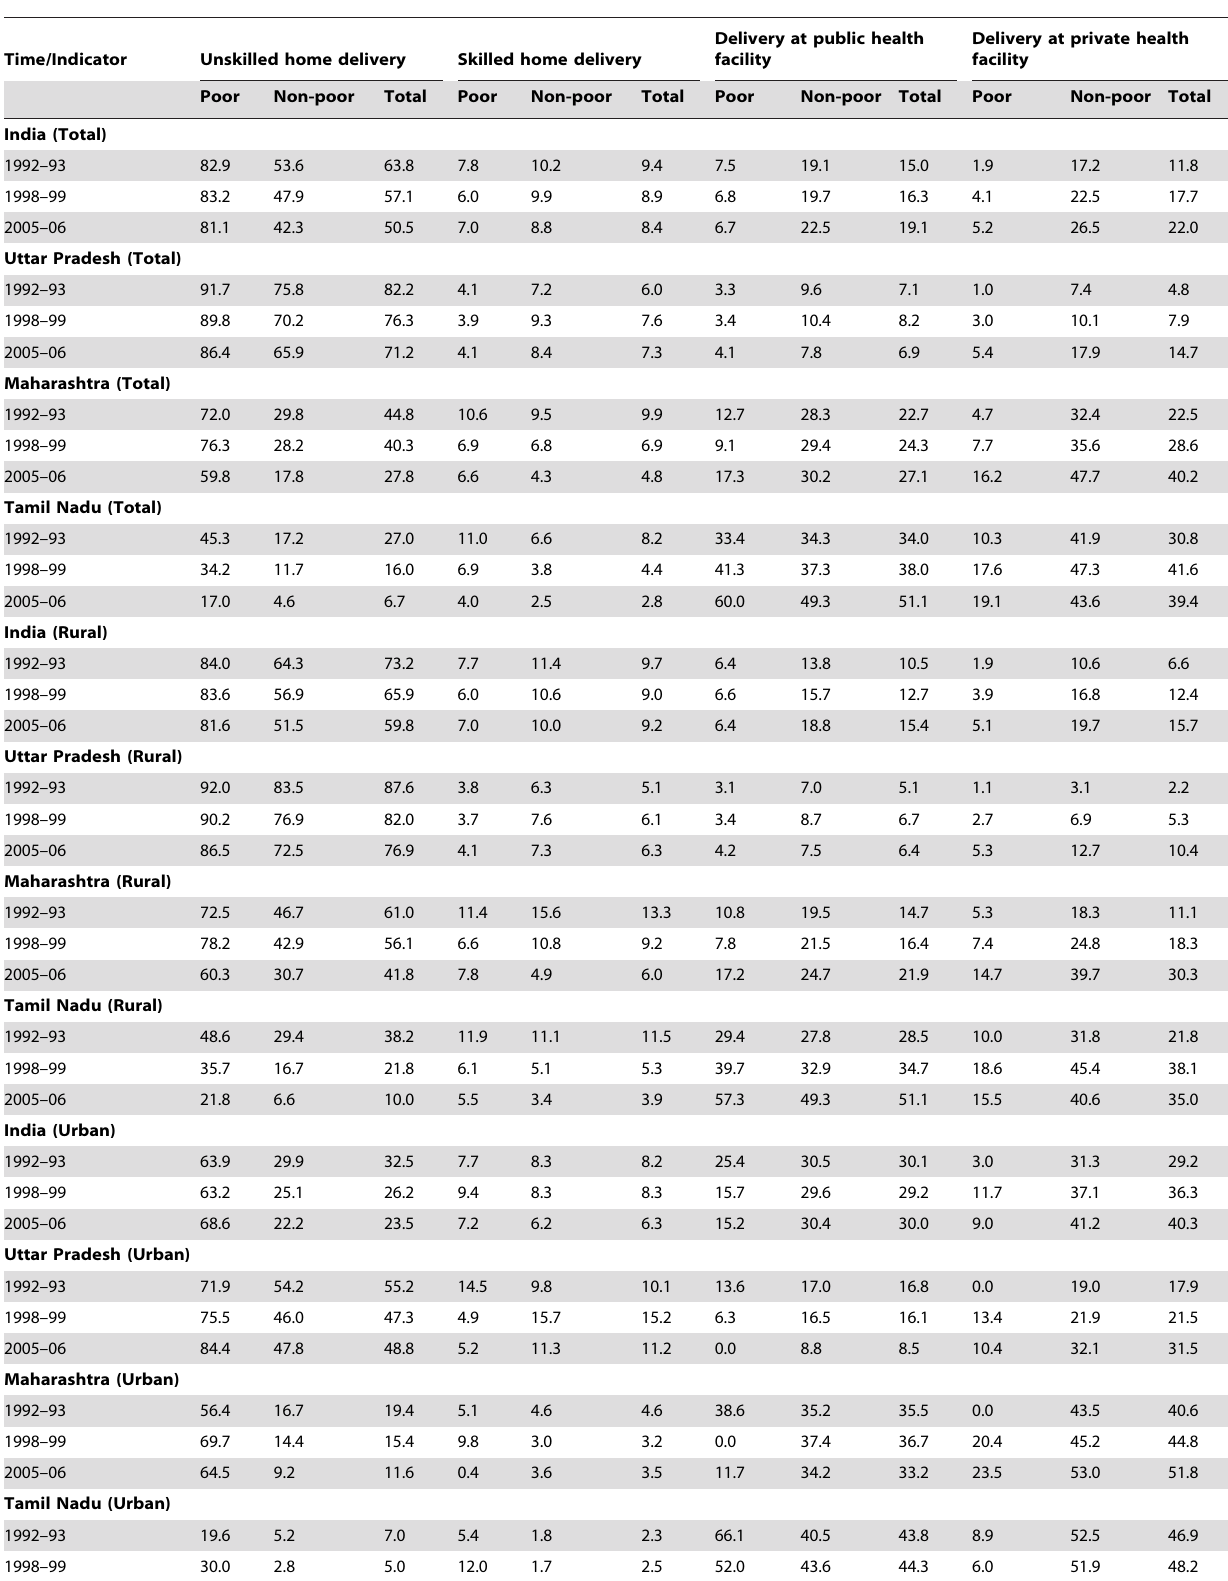
Table 5. Percent of birth assisted by skilled health professionals among poor and non-poor mothers by place of residence across selected states, India,